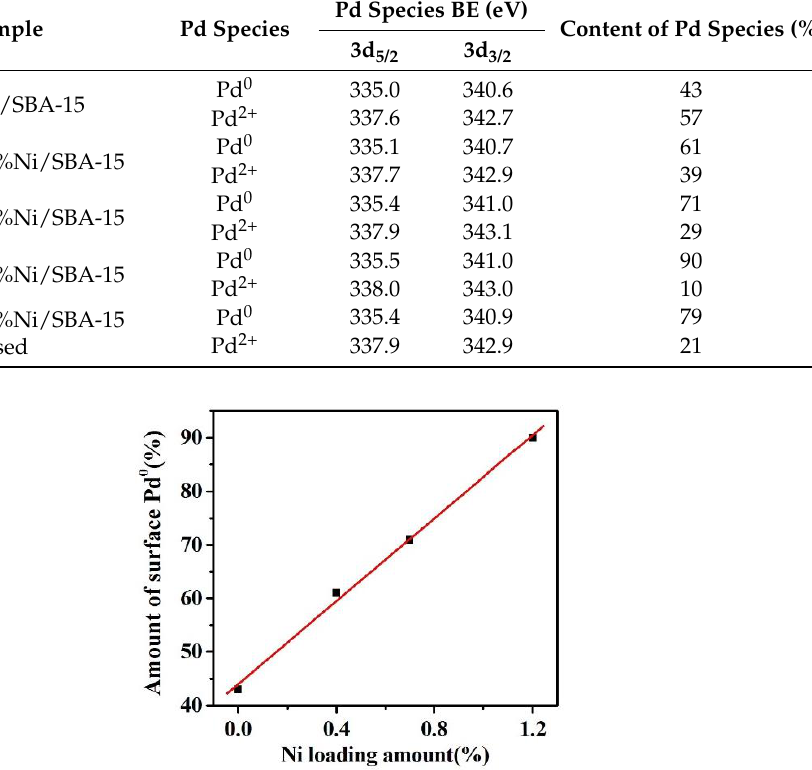
Table 2. XPS data of the Pd3d levels for different samples.